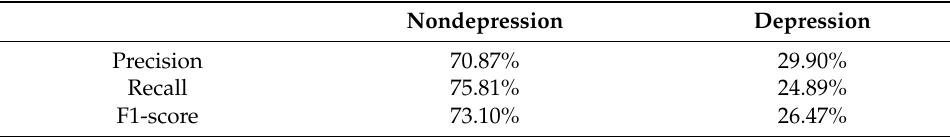
Table 10. Classification performance for the binary classification in Setting 2.